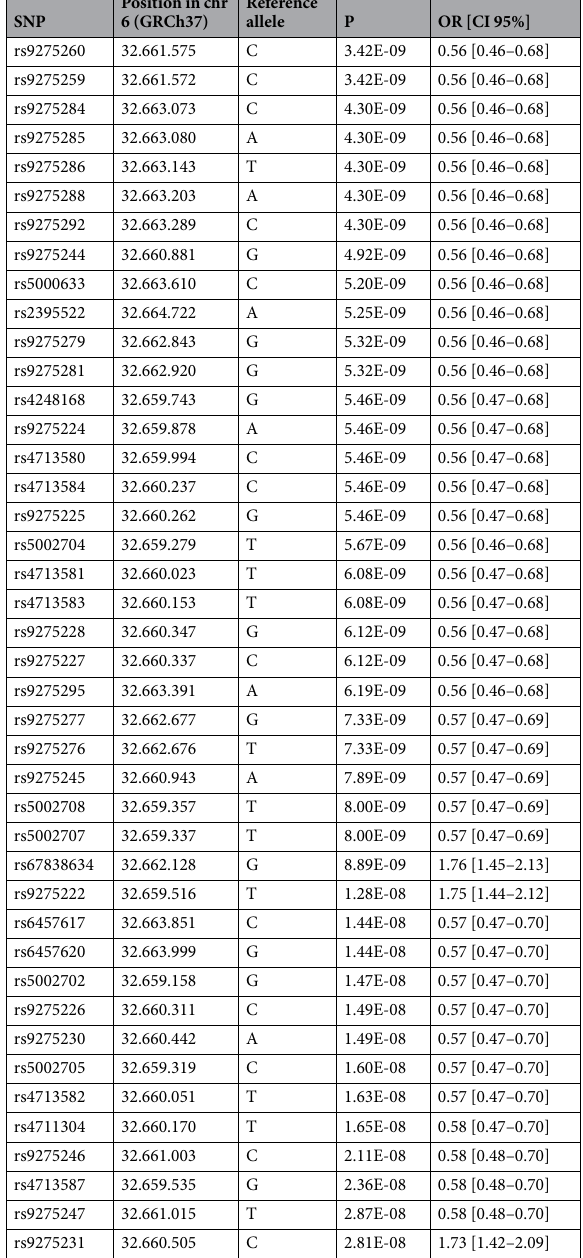
Table 1. Signals within HLA associated with IgA susceptibility at the GWAS significance level-P < 5E-08-after imputation of GWAS data. HLA: Human leukocyte antigen; IgA: Immunoglobulin-A; GWAS: genome-wide association study; SNP: single nucleotide polymorphism; chr: chromosome; OR: odds ratio; CI: confidence